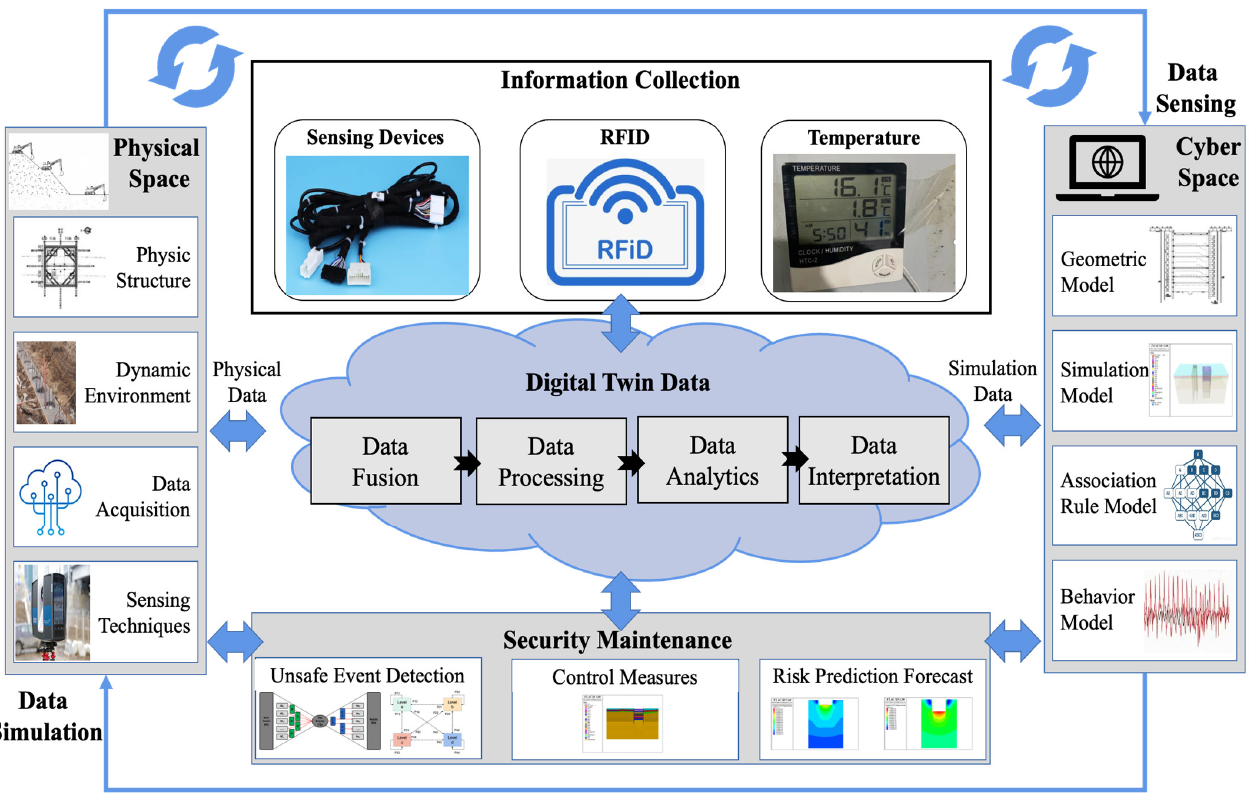
Figure 1. A vision: digital twin (DT)-based risk prognosis and control for safe and efficient FPE.